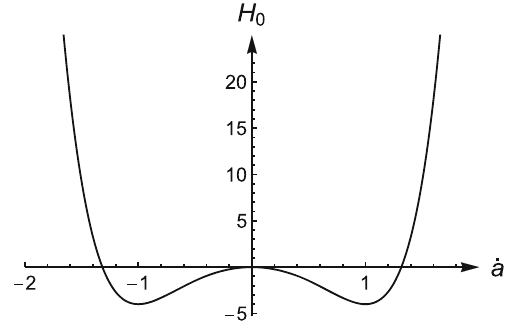
Fig. 1 Thesparrowtailintheleftplotischaracteristicwhenweinclude a higher-order kinetic term. The cusp singularities imply that ˙ a cannot be continuous at the tip. Instead the system tunnels from one vacuum to the other, keeping ˙ a 2 continuous. The right plot shows that H 0 ( ˙ a )